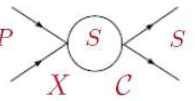
Fig. 5. A PV operator mixing with a strong S -wave operator. The PV operator parameter is X and the strong C is either the sin- glet or triplet, as required. The P -wave and S -wave portions are